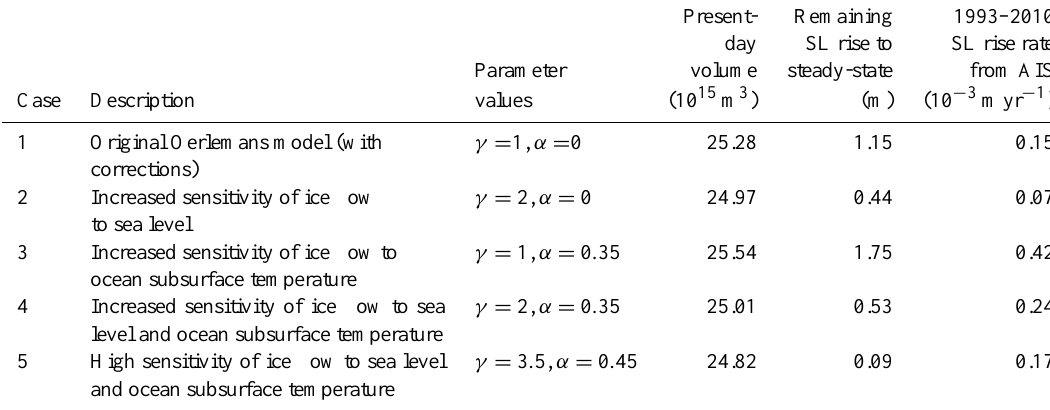
Table 2. Results for specific model configurations.